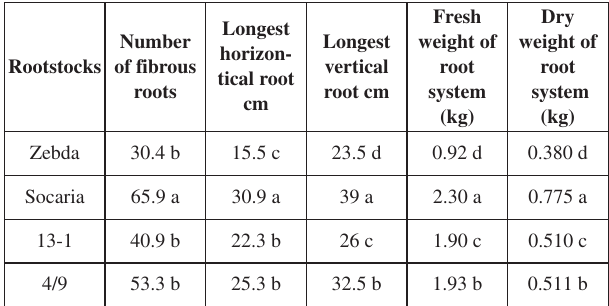
Table 2. Root parameter of the four tested rootstocks at the end of experiment in October 2007